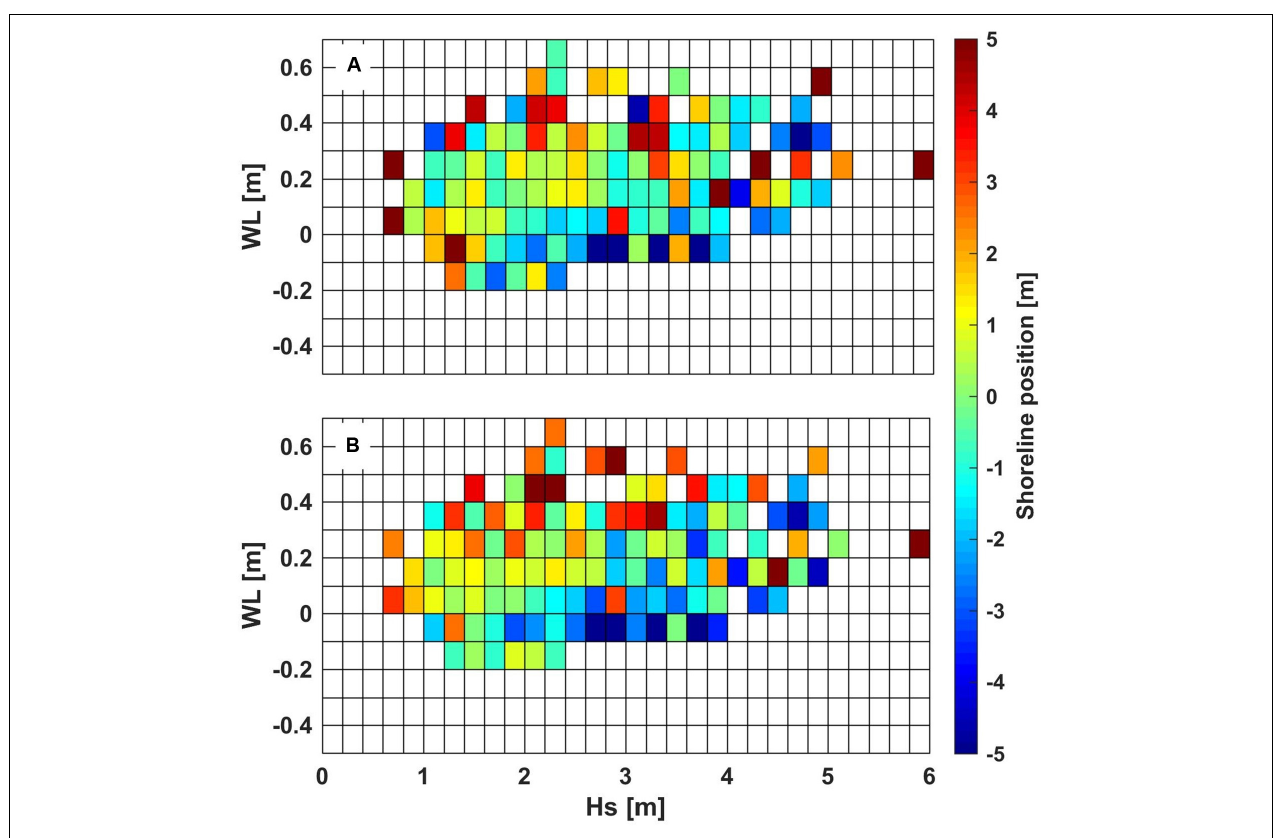
FIGURE 9 | Offshore subtidal water level (bin size 0.1 m, y-axis) and significant wave height (bin size 0.2 m, x-axis) compared to average shoreline positions at (A) Cell 3A and (B) 3B. The colors denote to the averaged shoreline position of all daily shorelines within each respective bin or the shoreline position in the event only one daily shoreline position fell within a